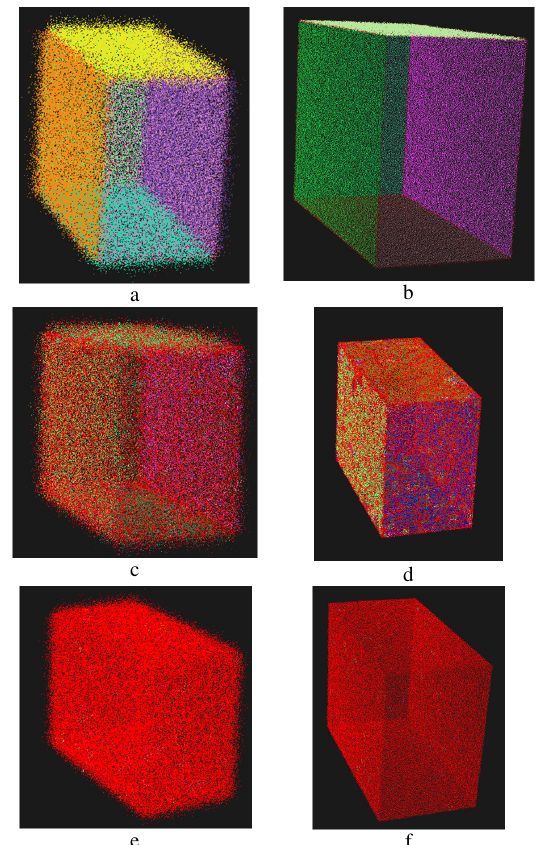
Figure 10. Region growing segmentation on a box point